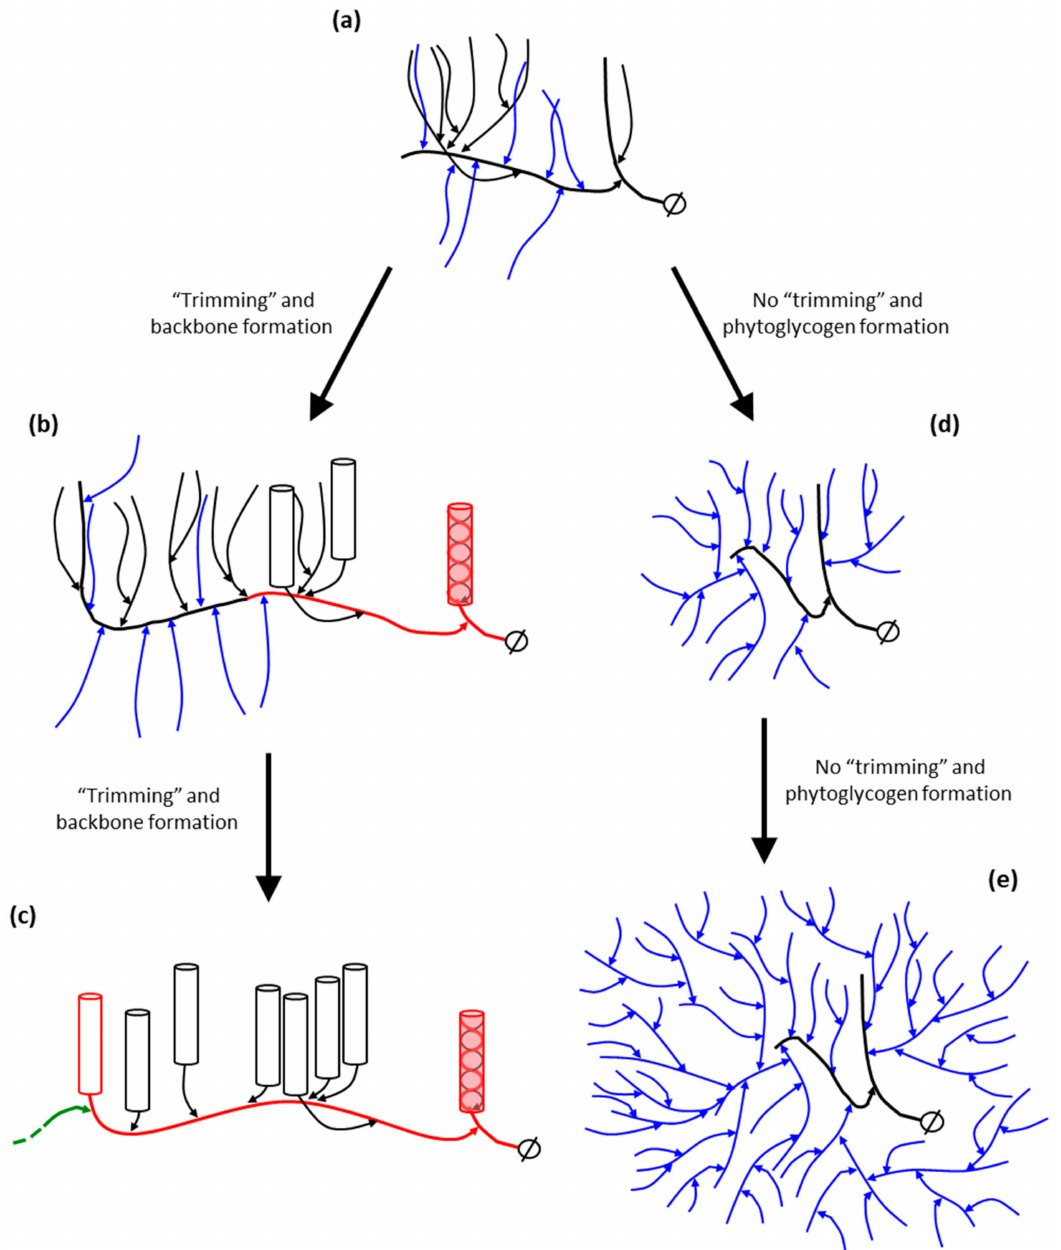
Figure 6. Thetrimminghypothesisofamylopectinadaptedtothebackbonemodel. ( a )A“pre-amylopectin” is formed by the action of SSs and SBE, having a tightly branched structure. ( b ) The “pre-amylopectin” is “trimmed” through removal of chains (blue) by the action of DBE to form the backbone (red) with characteristic inter-block segments between the branched building blocks. The short chains that remain after the trimming form double-helices (cylinders). External chains of the long chains forming the backbone participate in double-helices (red cylinders). The backbone chain is elongated and extensively branched simultaneously with the trimming events. ( c ) The elongated structure is trimmed and the backbone continuoustobeelongatedeventually, withanewchainstub(green)introducedbySBEs. ( d )Anextensively branched molecule is formed without the trimming action, and ( e ) a water-souble phytoglycogen molecule is eventually the result of a continuous branching and chain elongation in the absence of DBE